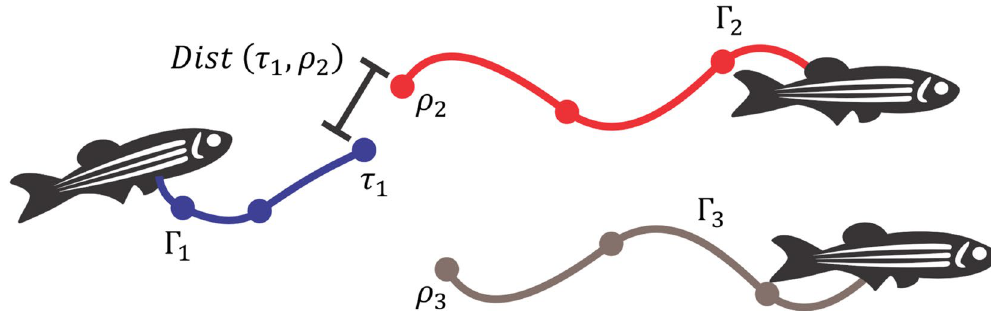
Figure 4. Reconnection of the trajectory of the fish. In this situation there is an interrupted trajectory Ŵ 1 and two new trajectories Ŵ 2 e Ŵ 3 . For trajectory connection Ŵ 1 the condition of Eq. (16) is verified with respect to the trajectories Ŵ 2 e Ŵ 3 . If the result is true for both trajectories, the trajectory chosen for the connection is the one with the shortest distance defined by Eq. (17). In the figure, the lowest value is Dist (ρ 2 , τ 1 ) , then their trajectories can be